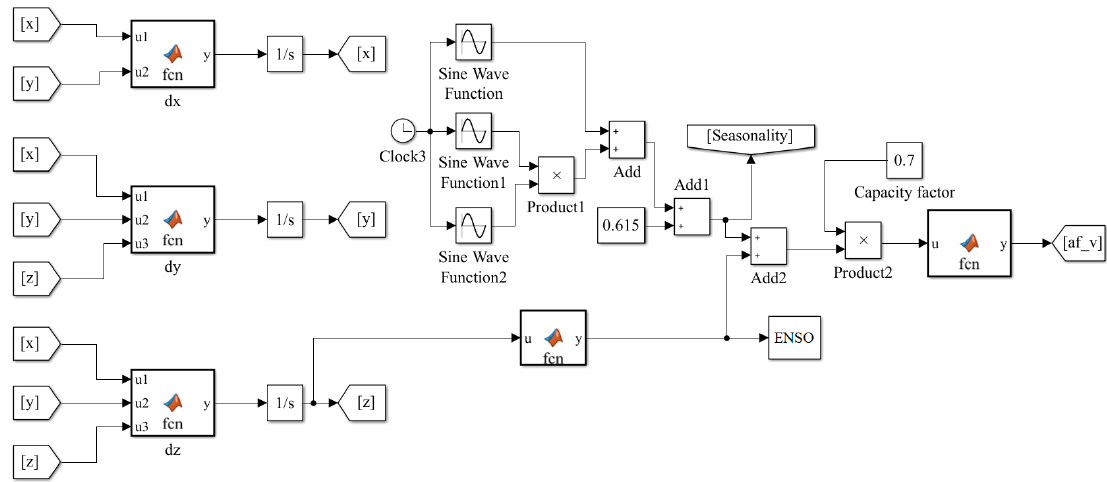
Figure 8. The DS modeling approach of the ENSO phenomenon. Simulink block diagram of af v